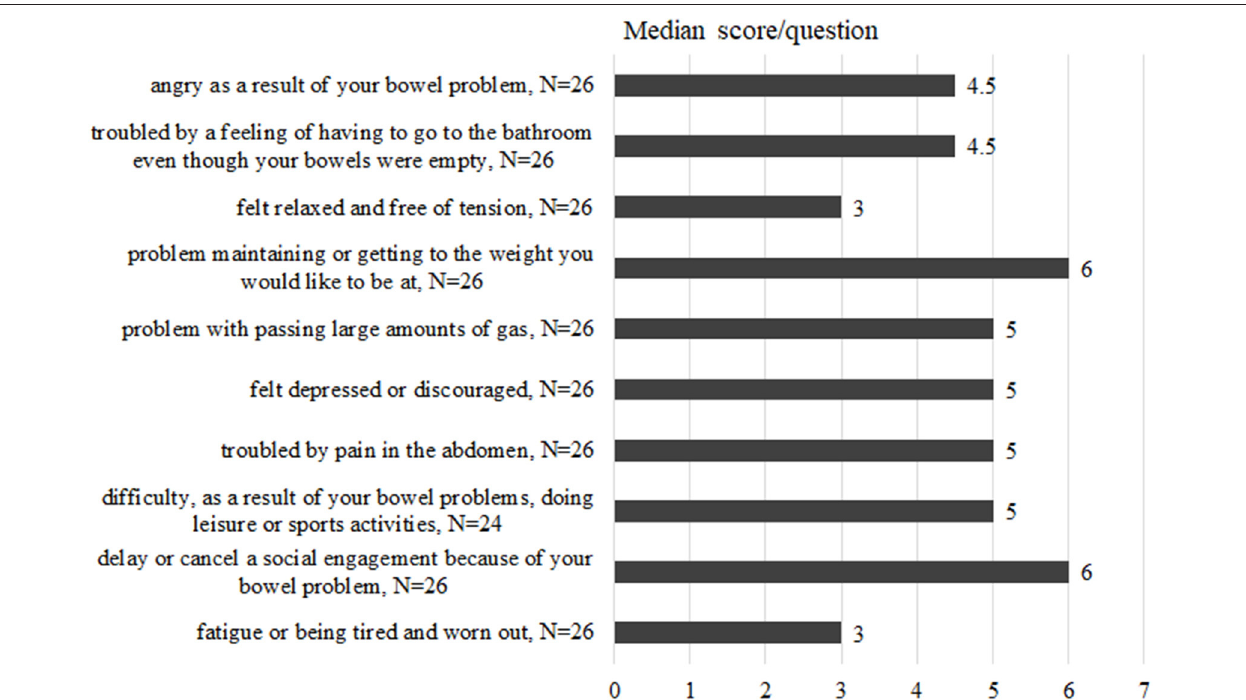
FIGURE 4 | Replies from the sIBDQ completed by 26 CVID patients with current diarrhoea. Questions ask about the impact of bowel problems and quality of life during the last 2 weeks. For each item there is a 7-point Likert scale ranging from 1 for the worst to 7 for the best quality of life in this item. Higher scores represent a better quality of life. Medians for each reply are given in this